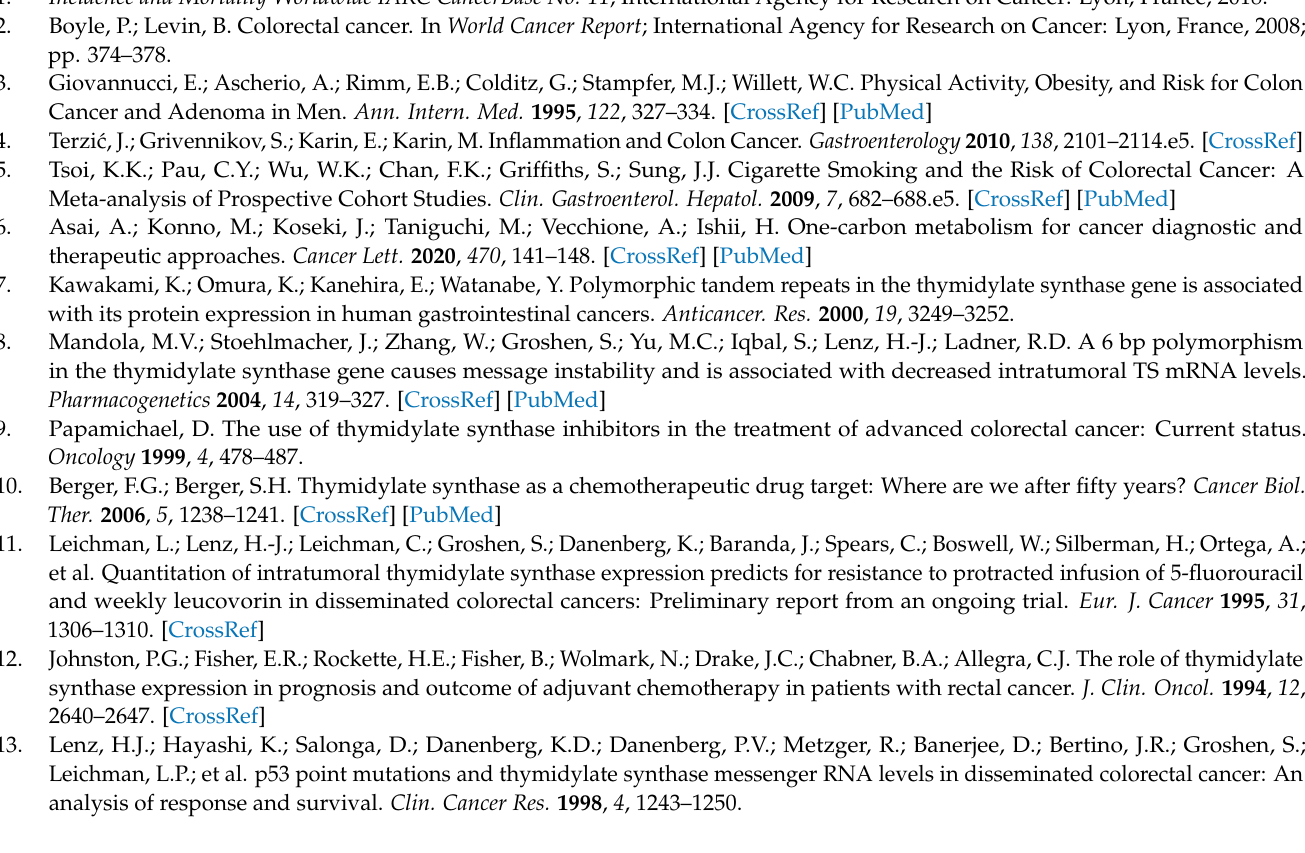
CRC incidence. Table S2: Survival analysis of TS 3’-UTR polymorphisms in CRC patients. Table S3: Survival analysis for combined genotypes and haplotypes TS in CRC patients. Table S4: Adjusted hazard ratios of prognosis risk factors on CRC patients according to TS 3’-UTR polymorphisms. Table S5: TS mRNA expression according to 3’-UTR genotypes or haplotypes. Table S6: TS, miR-124-1, and miR-203 expression levels according to TS 3’-UTR